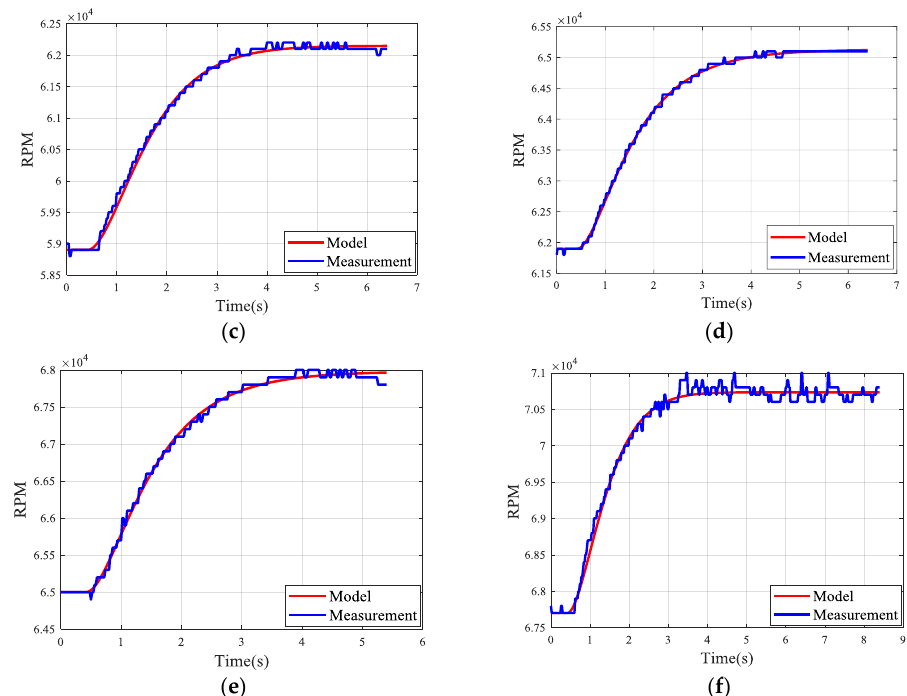
Figure 9. Comparison between real and simulated response. ( a ) 51,900–55,500; ( b ) 55,500–58,900; ( c ) 58,900–61,900; ( d ) 61,900–65,000; ( e ) 65,000–67,800; ( f ) 67,800–70,800.